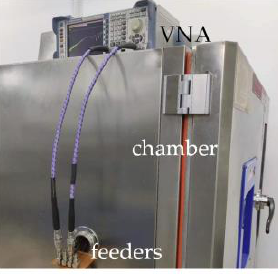
Figure 8. Photo of experiment devices used to measure thermal phase stability.